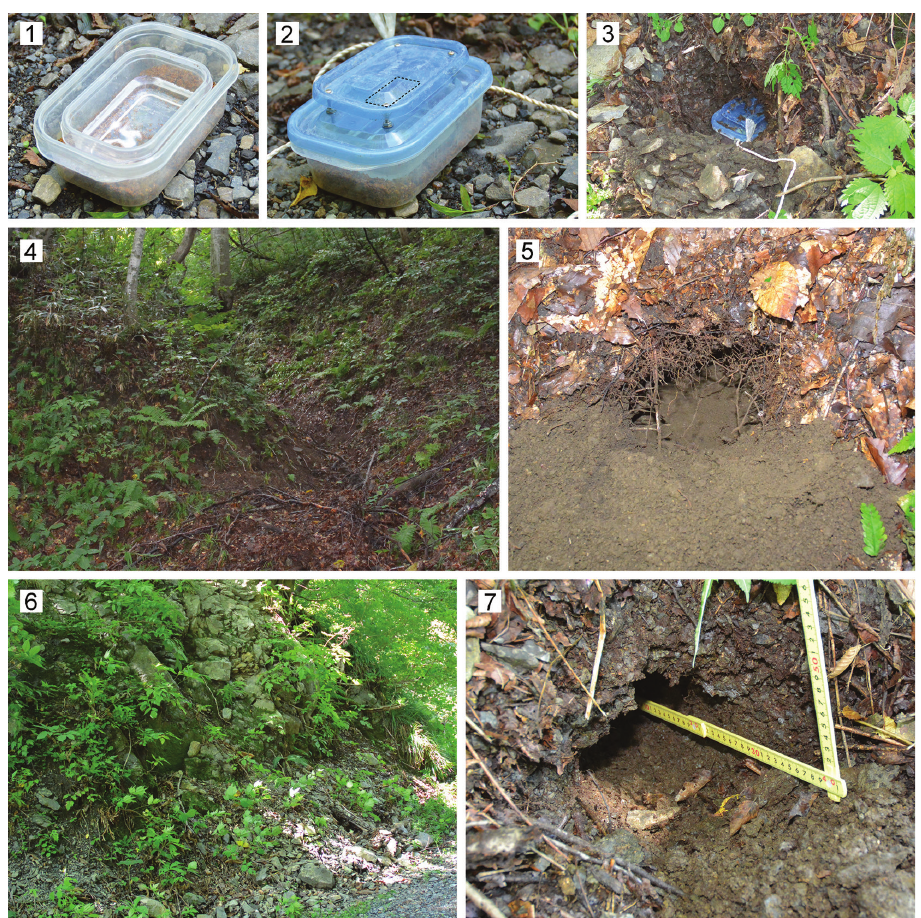
Figures 1–7. Design of subterranean baited traps and the aboveground and subterranean environments at the collection sites. 1 Trap without cover, showing sections containing attractant (larger container) and preservative (smaller container) 2 Trap with cover, showing the entrance section (square with broken lines) 3 Trap installed in hole, showing nylon cord, part of which will be left aboveground as a marker 4 Aboveground environment of the Pterostichus shinbodakensis type locality 5 Hole for the trap at the P. shinbodakensis type locality, showing the subterranean environment 6 Aboveground environment of the P. tateishiyamanus type locality 7 Hole for the trap at the P. tateishiyamanus type locality, showing the subterranean environment. The magnifications of the photos vary (see text for trap